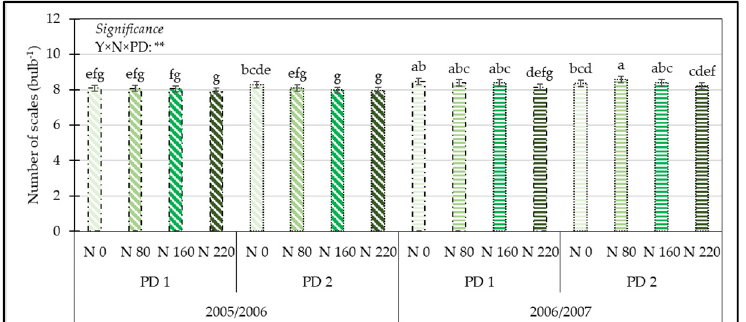
Figure 4. Influence of the interaction Y × N × PD on the number of scales. Means with the same letter are not significantly different at p ≤ 0.05 according to Tukey’s test. Bars represent the standard error. ** = significant at p ≤ 0.01; Y = Year; N = Nitrogen; PD = Planting Date; N 0 = No-Nitrogen Fertiliza- tion; N 80 = fertilization with 80 kg N ha − 1 ; N 160 = fertilization with 160 kg N ha − 1 ; N 220 = fertilization with 220 kg N ha − 1 ; PD 1 = Early Planting Date; PD 2 = Traditional Planting Date. For the dry matter percentage and total yield, ANOVA showed a significant influ- ence of the interaction A × N × PD (Table S1). The highest dry matter percentage was recorded in non-fertilized plots, PD 2, and the V1 accession. The lowest values were ob- served in the combinations L1 × PD 1 × N 160, L1 × PD 1 × N 220, V1 × PD 1 × N 80, V1 × PD 1 × N 160, and V1 × PD 2 × N 220 (Figure 5A). The highest total yield values were linked with the L1 accession planted during the traditional period and fertilized with 160 or 220 kg N ha − 1 , whereas the lowest total yield was shown by the V1 accession planted in the early period and non-fertilized with nitrogen (Figure 5B).